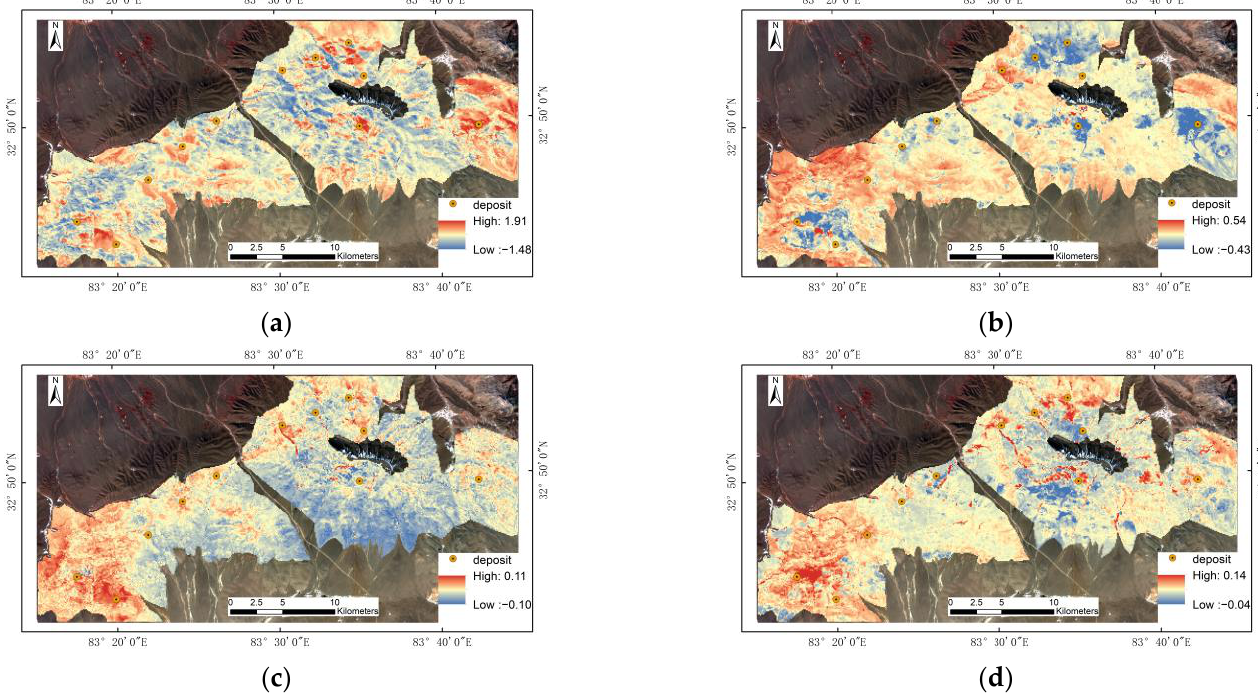
Figure 9. The first four PCs based on the GF-5 SWIR data: ( a ) PC1; ( b ) PC2; ( c ) PC3; and ( d ) PC4.